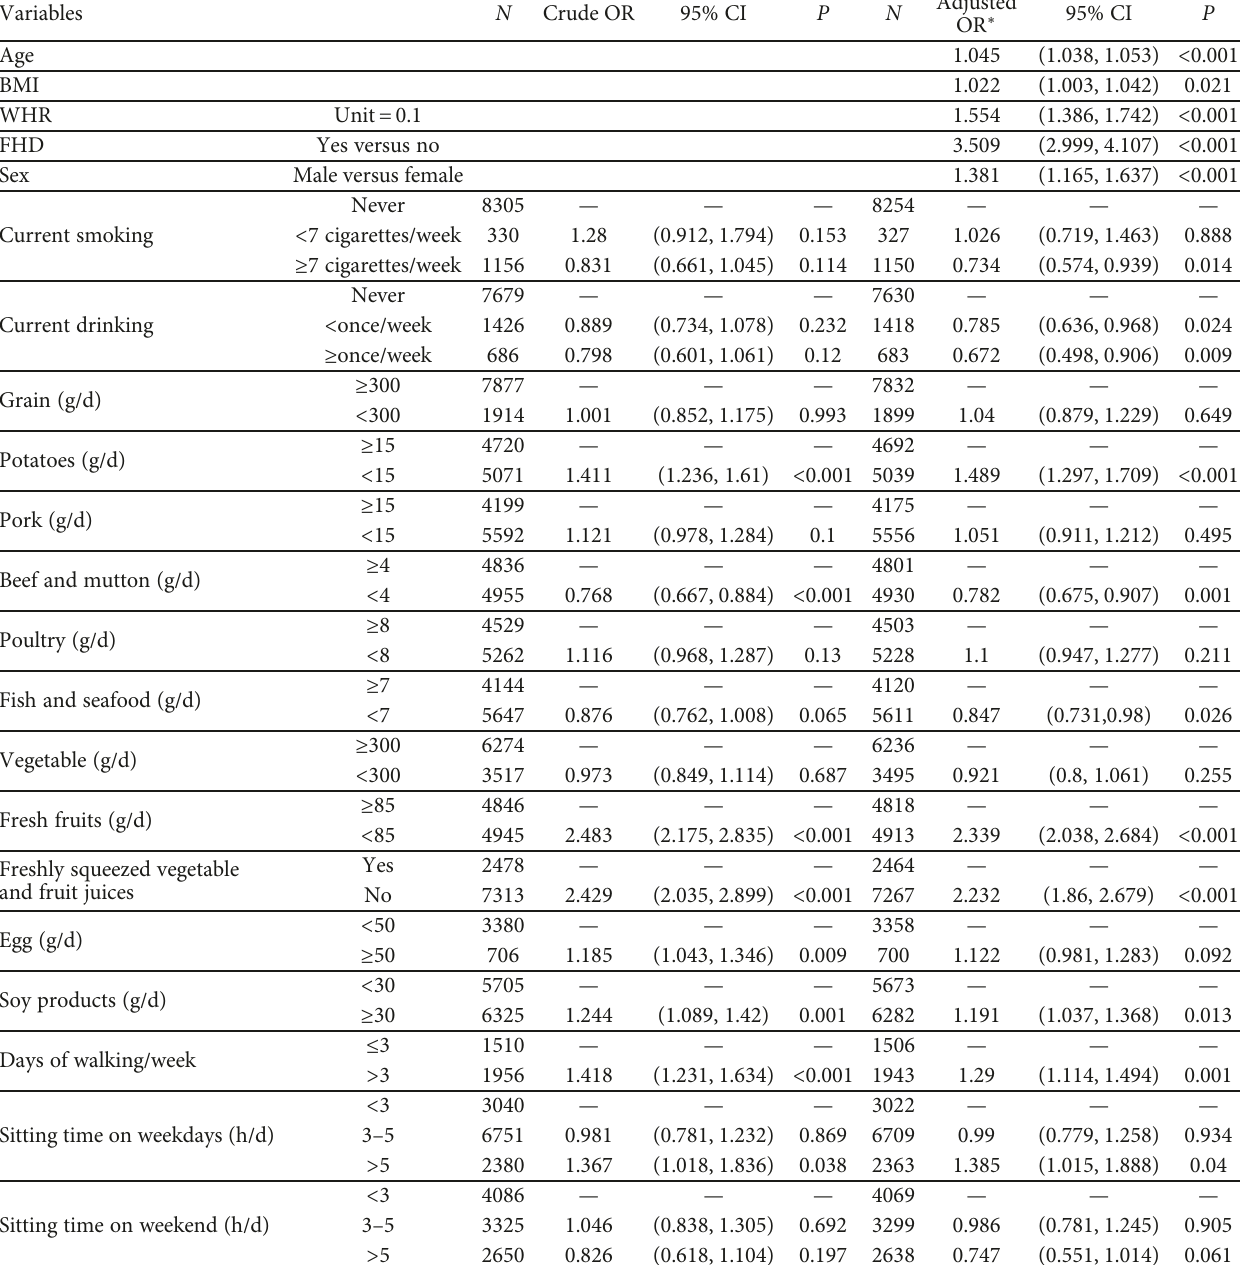
Table 4: Multivariate analysis of associations between T2DM and